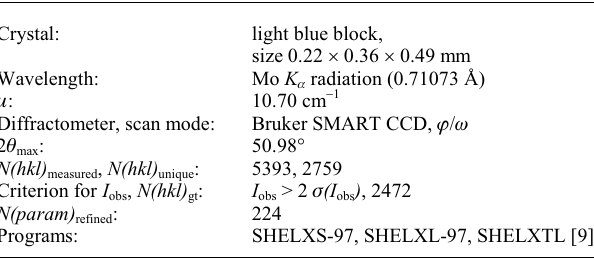
Table 1. Data collection and handling.